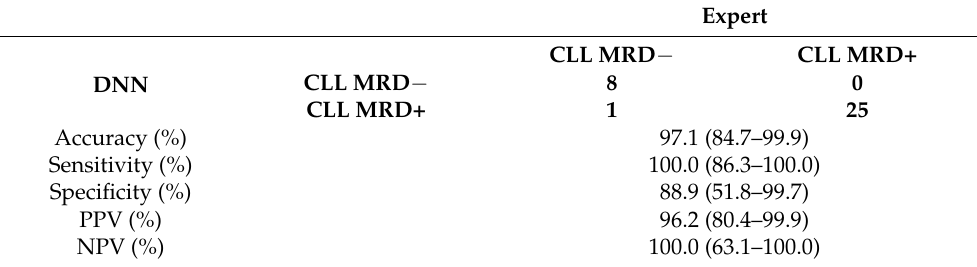
Table 3. CLL MRD status designation comparison between expert-gated (ground truth) and DNN- gated cases in the independent validation cohort (34 unknown cases, excluding serial dilution